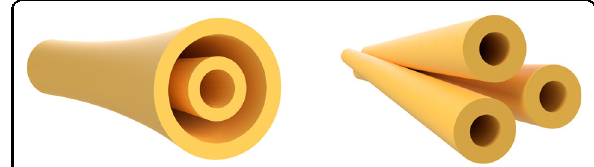
Fig. 1 Two types of modes. A schematic diagram of LG beam (left) and MVGB